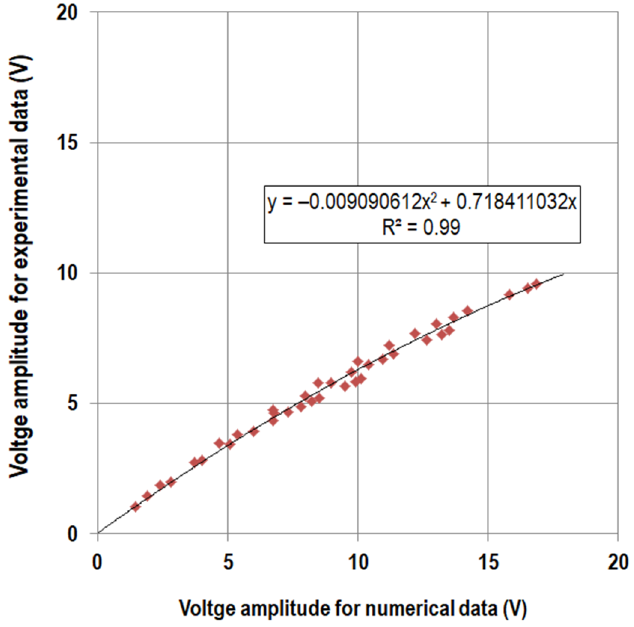
Figure A2. Voltage amplitudes (V) from sinusoidal fitting for numerically calculated data against amplitudes for experimental data and regression curve.